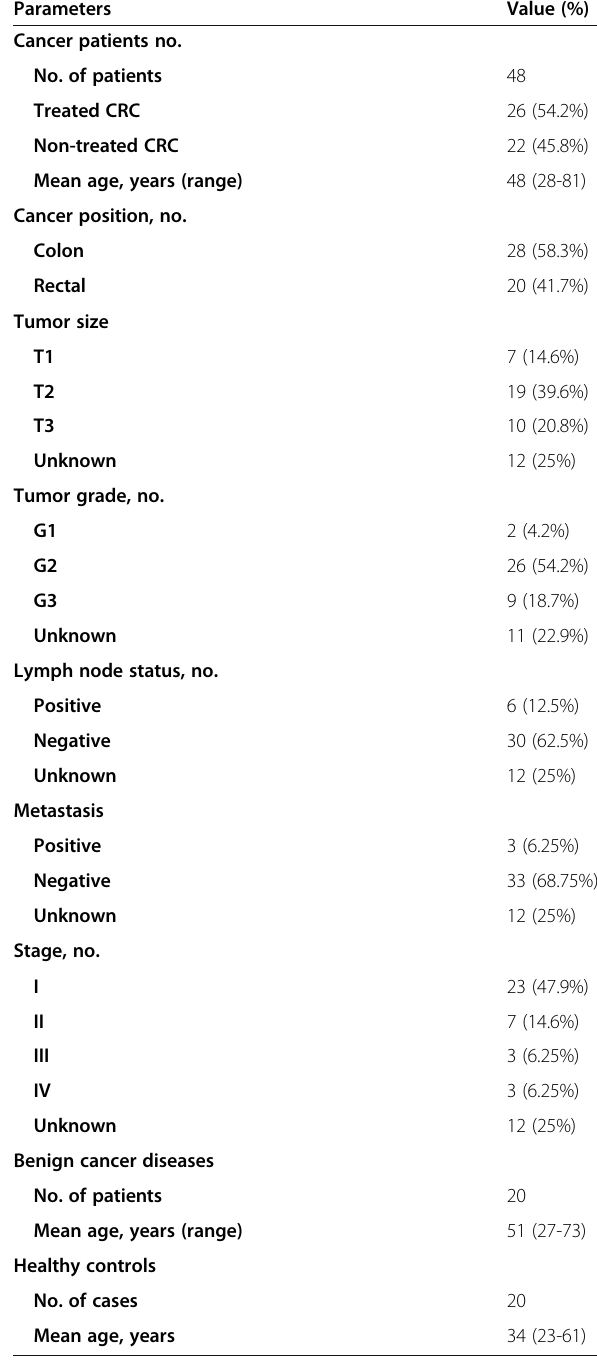
Table 1 Clinicopathologic parameters of patients with colorectal cancer and control